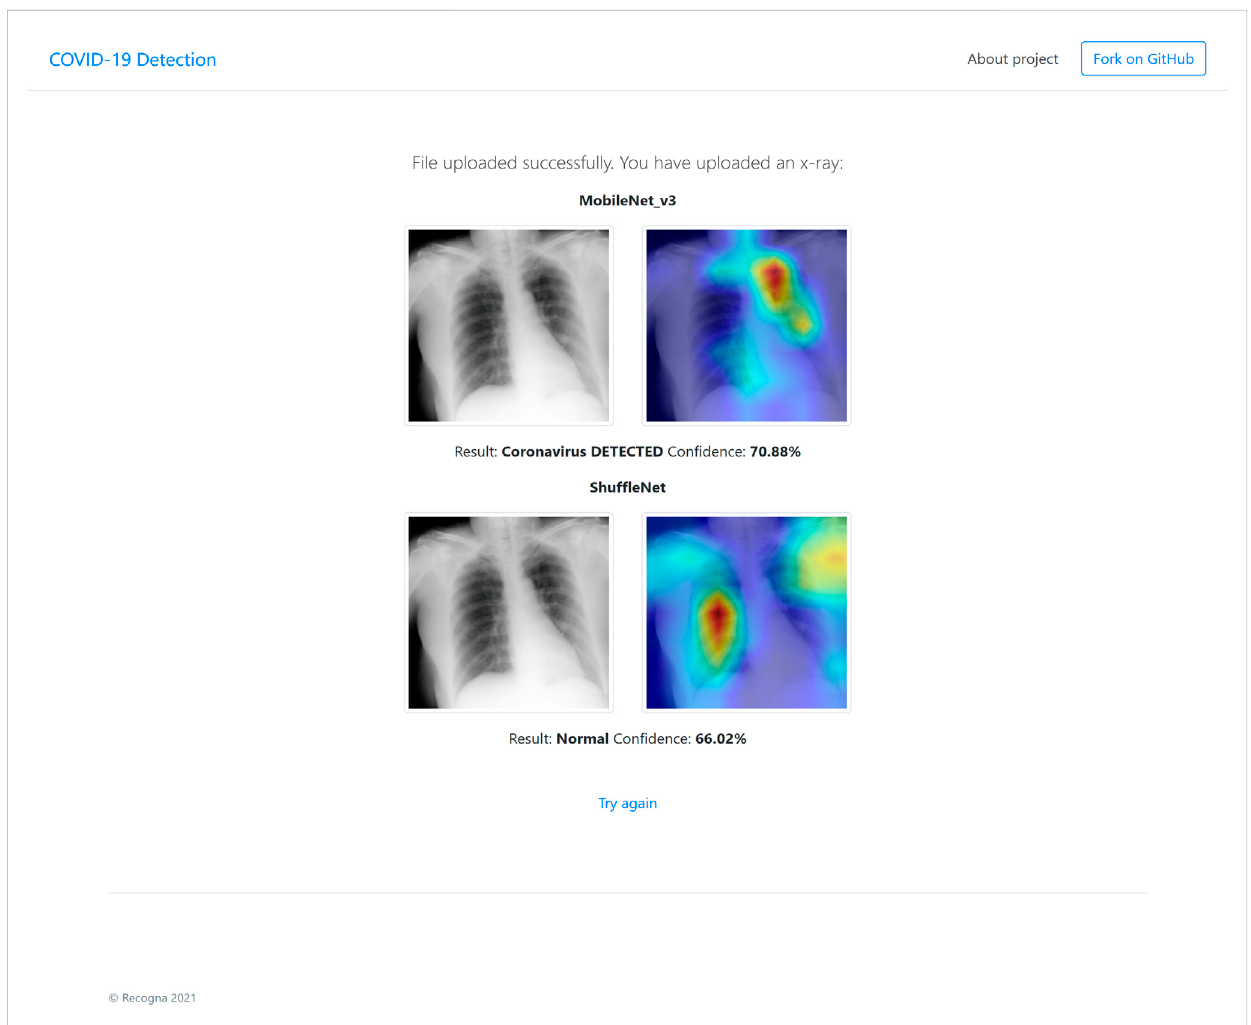
FIGURE 11 Outcome screen with the outputs given by each neural model selected in the previous step. A heatmap is also